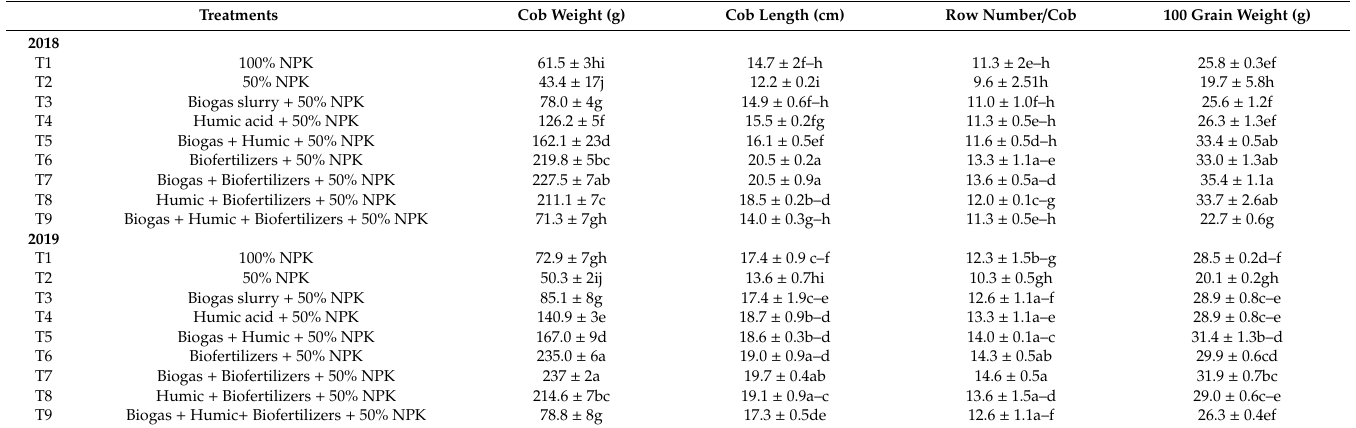
Di ff erent letters following the data within each column mean significant di ff erence at p < 0.05.